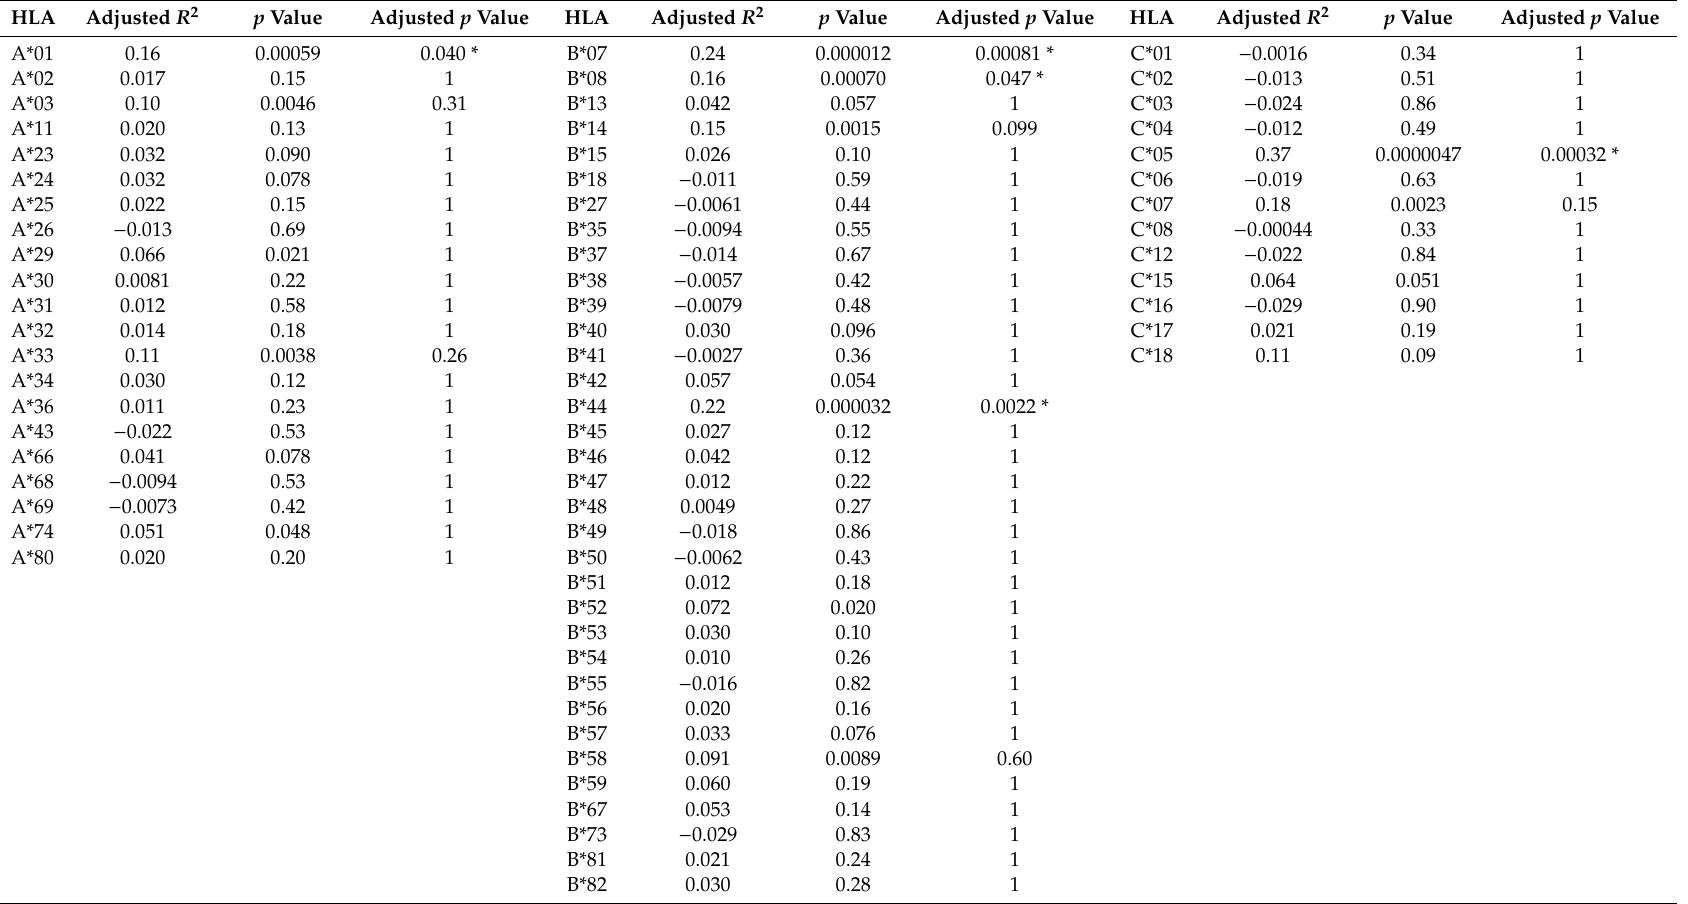
Table 1. Results of linear regression and adjusted p values. HLA: human leukocyte